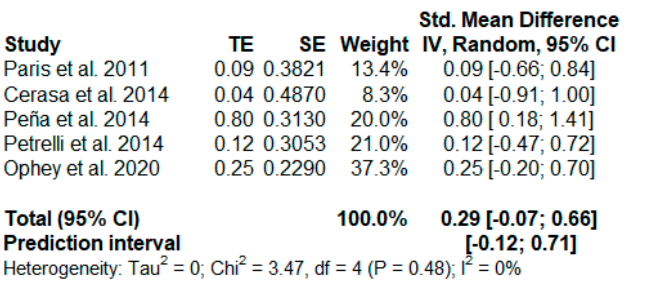
Figure 7 . Efficacy of cognitive rehabilitation in visual memory.